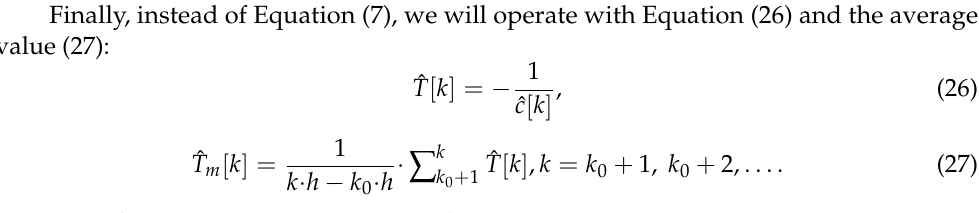
Figure 6. Block diagram of the discrete-time tracking subsystem.